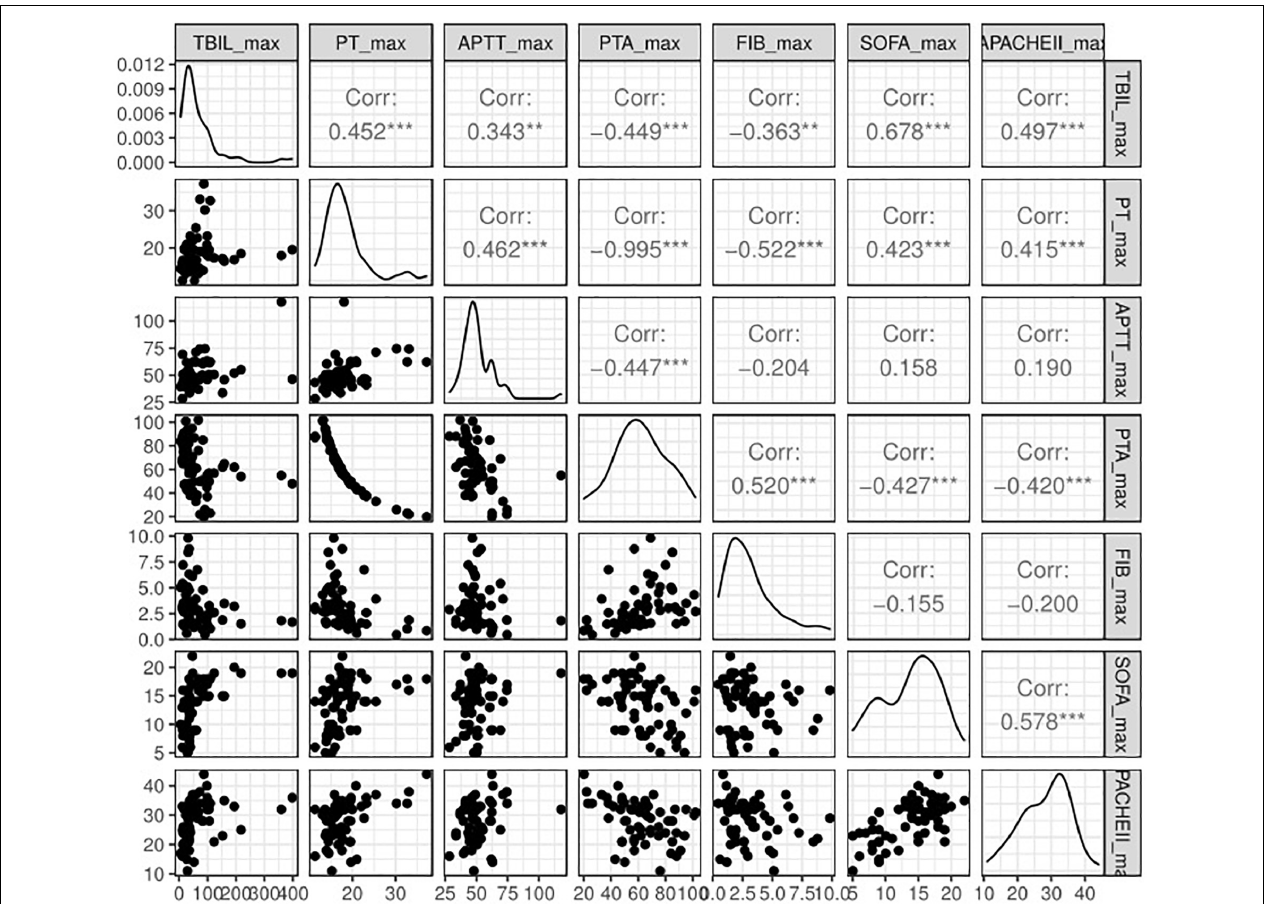
FIGURE 4 | Spearman correlation analysis of peak TBIL and other simultaneous clinical parameters. TBIL, total bilirubin; PT, prothrombin time, APTT, activated partial thromboplastin time; PTA, prothrombin time activity; FIB, fibrinogen; SOFA, Sequential Organ Failure